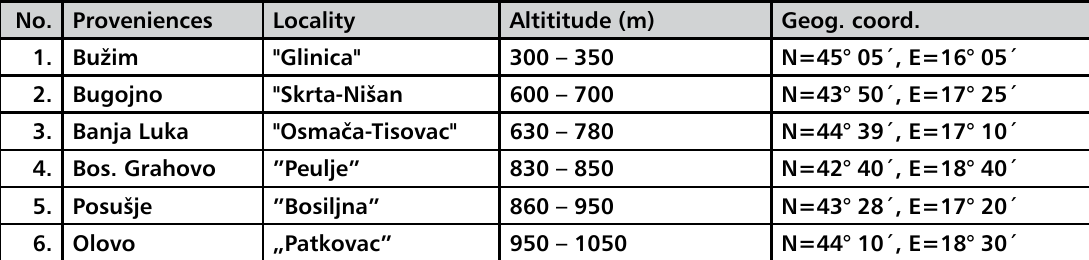
Localities of particular proveniences with geographic coordinates no. Proveniences